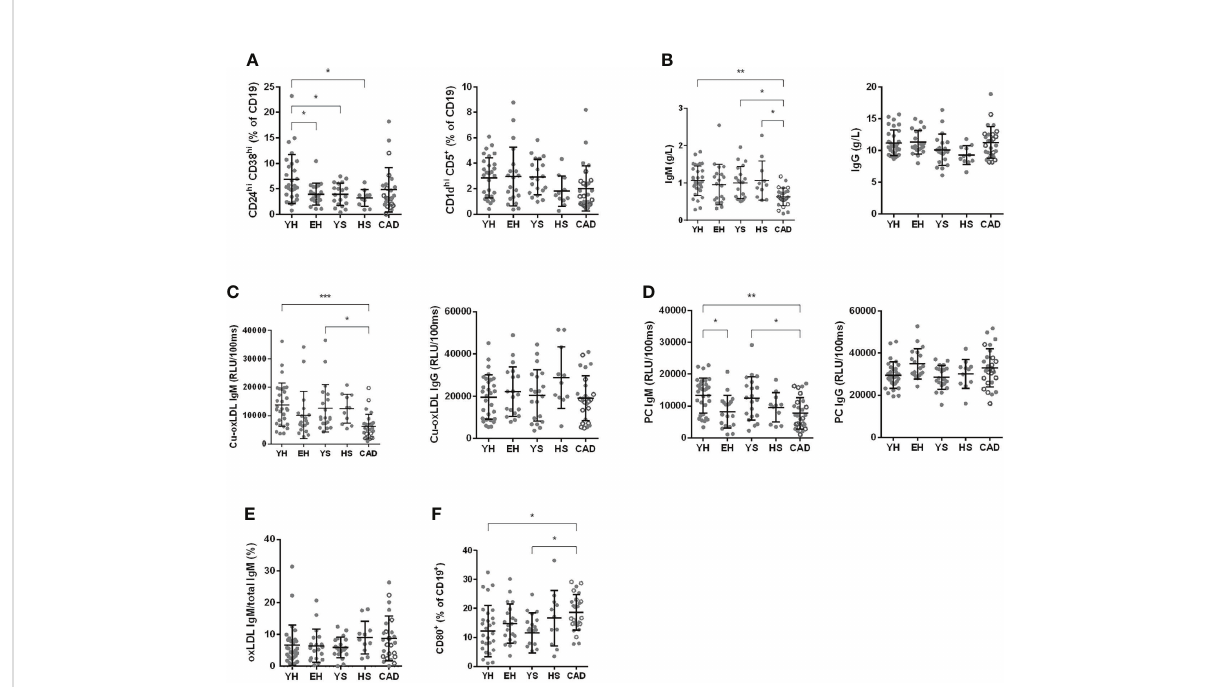
FIGURE 6 Effect of ageing and smoking on B cells. Number of CD24 hi CD38 hi and CD1d hi CD5 + regulatory B cells, evaluated by fl ow cytometry (A) . Total IgM and IgG as assessed at the clinical chemistry lab at LUMC (B) . oxLDL speci fi c IgM and IgG (C) as well as PC IgM and IgG (D) as assessed by ELISA. oxLDL secreting B cells were measured using ELISpot after 3 days of stimulation with R848 and IL-2 and are expressed as percentage of total IgM secreting B cells (E) . CD80 expression was measured by fl ow cytometry on isolated B cells after 24 hours of stimulation with CpG B (F) . YH, young healthy; EH, elderly healthy; YS, young smoker; HS, heavy smoker; CAD, coronary artery disease patient. Open circles in the CAD group represent the smokers. Statistics was performed using one-way ANOVA with Dunnett ’ s post hoc test or Kruskall-Wallis test with Dunn ’ s post hoc test, means were compared to the YH group. P values ≤ 0.05 are considered signi fi cant. * p ≤ 0.05, ** p ≤ 0.005, *** p ≤